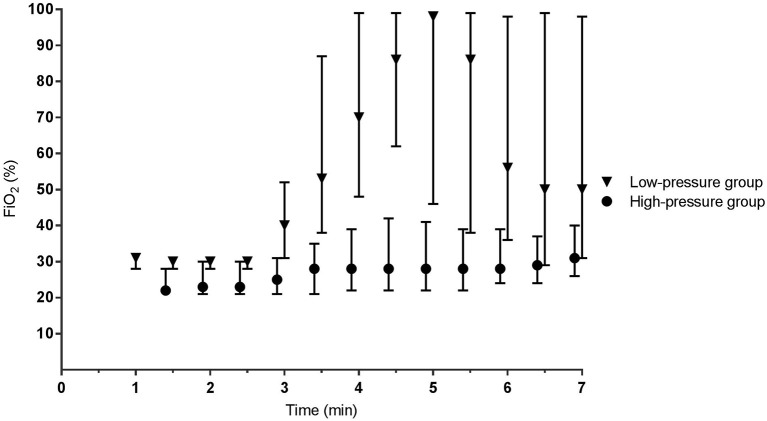
Fraction of inspired oxygen. Data is presented as median (IQR).